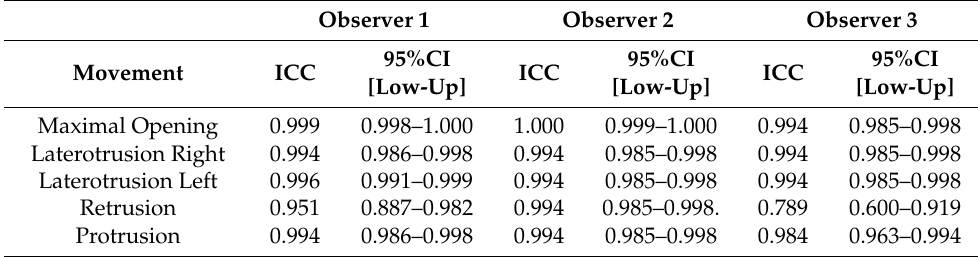
Table 2. ICC estimates for intra-rater reliability and their 95% confidence intervals.